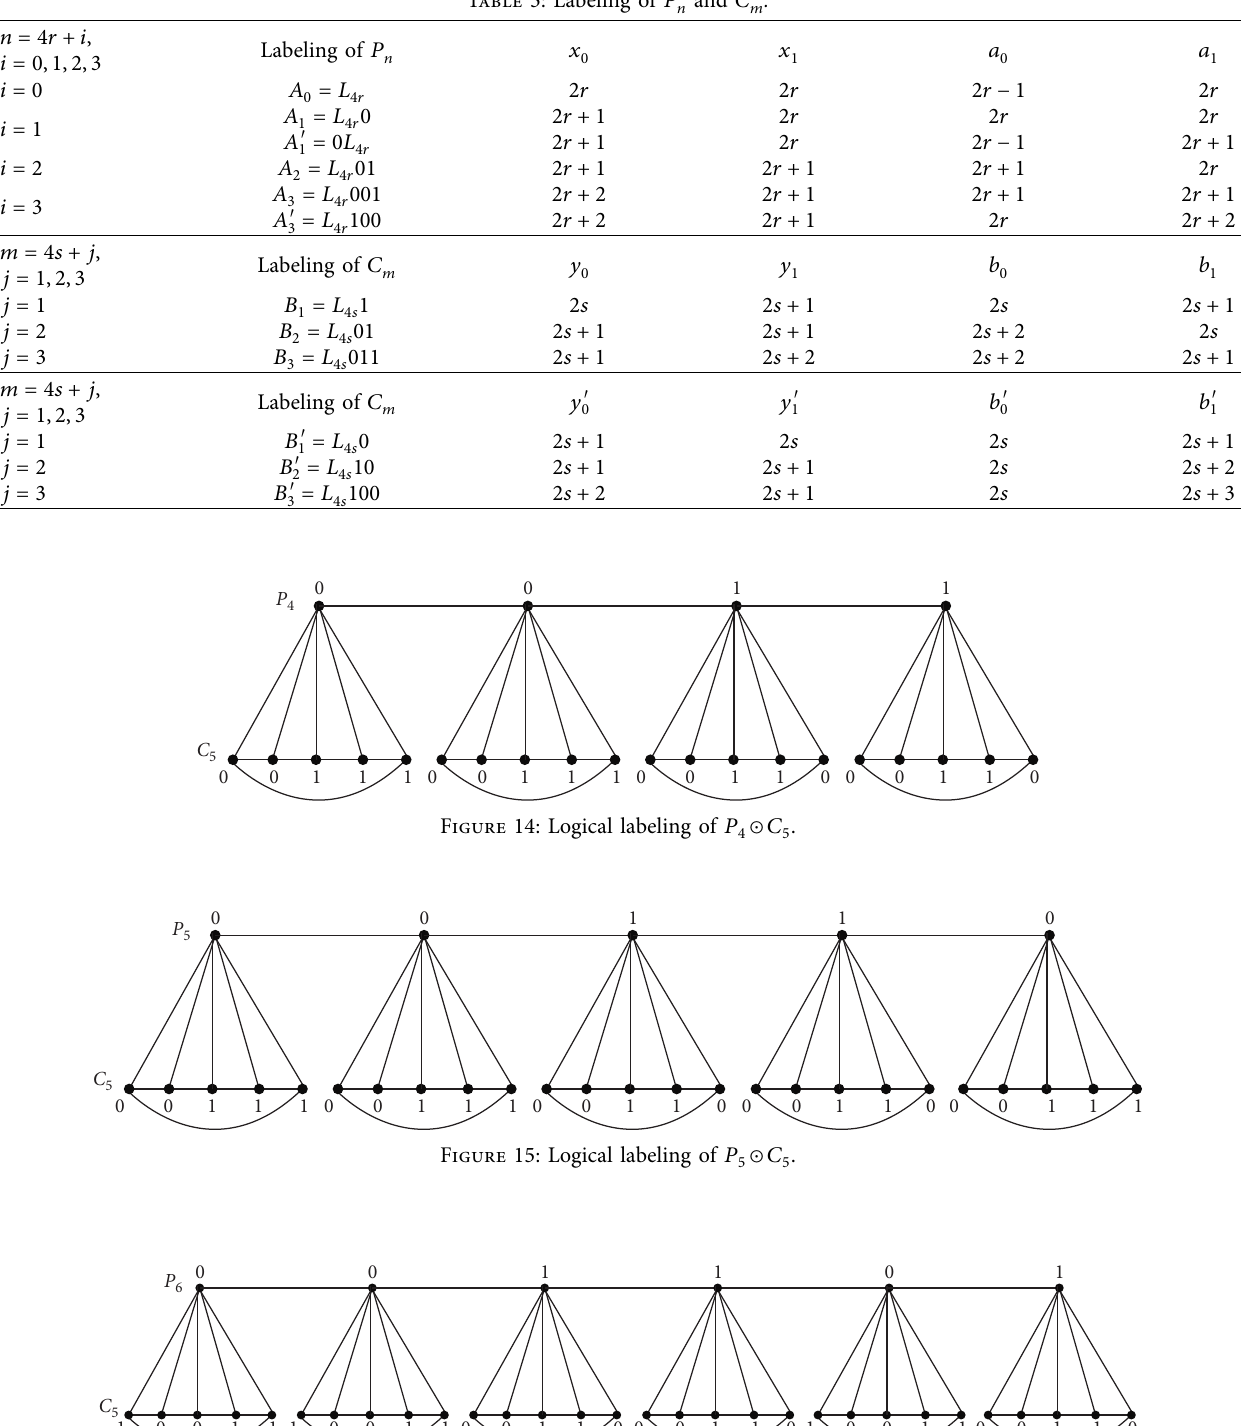
Table 3: Labeling of P